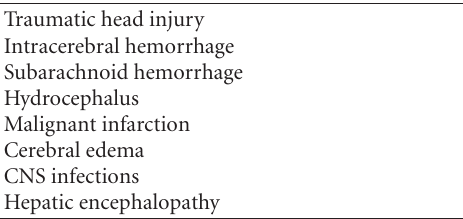
Table 1: Conditions where ICP-monitoring is